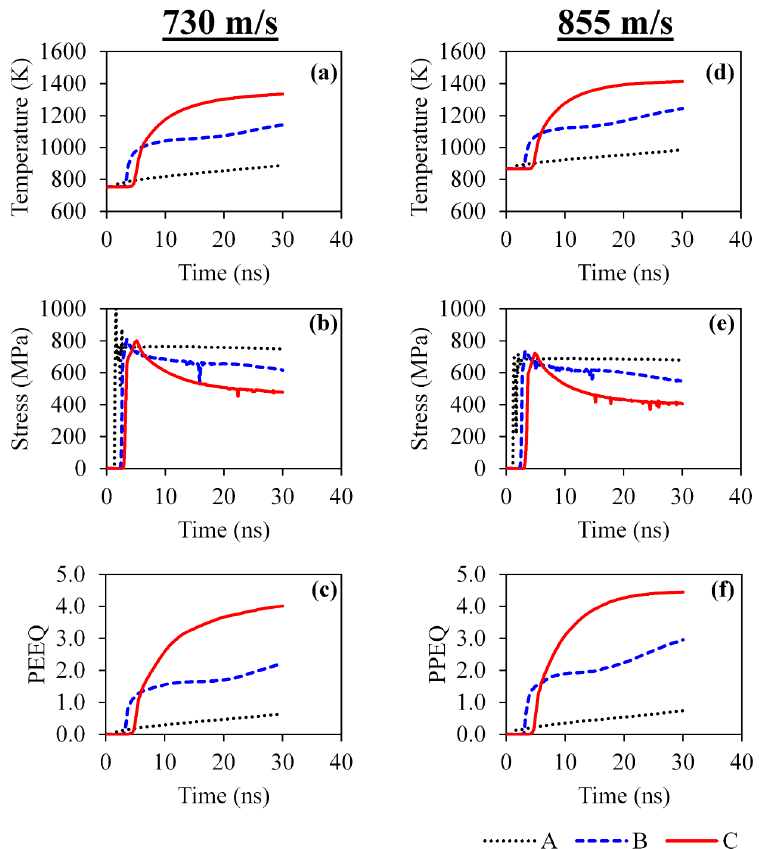
Figure 13. Stress, strain and temperature evolutions of elements A, B and C (as shown in Figure 12) at the Ti64 particle interface when impacted with velocities of ( a – c ) 730 and ( d – f ) 855 m/s for the duration of 30